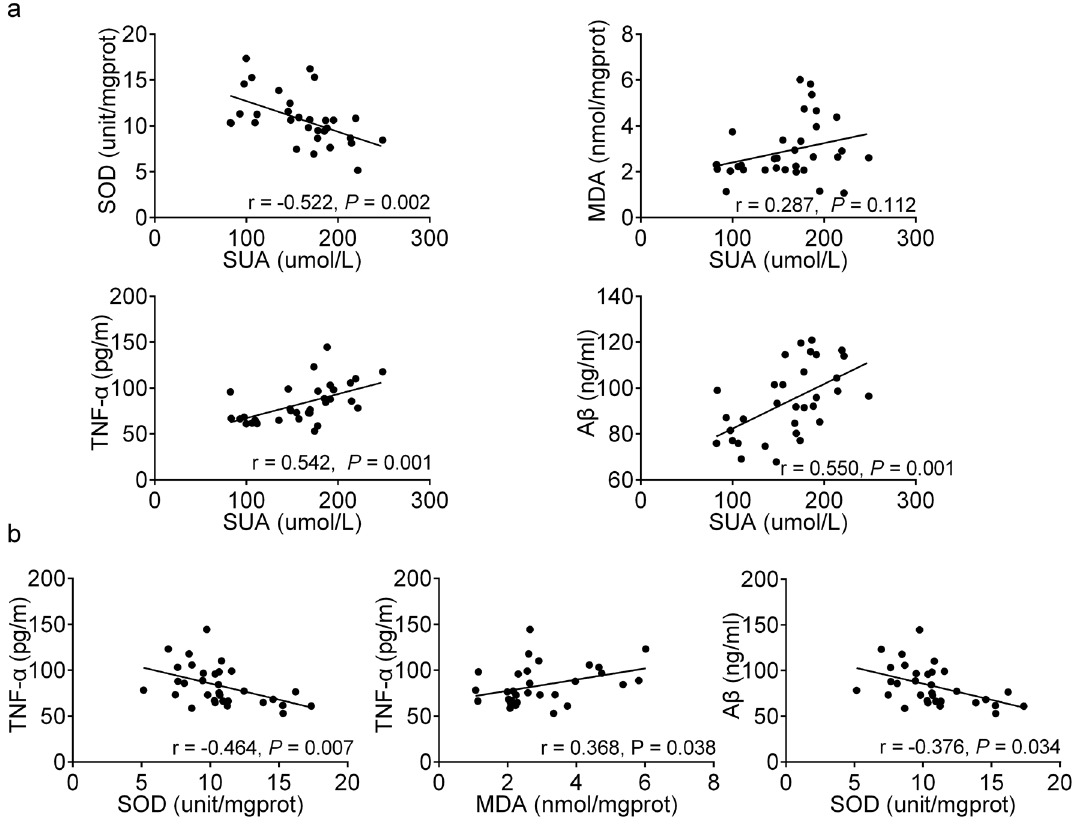
Figure 4. Associations between SUA at week 48, oxidative stress, inflammation cytokines and Aβ. n (subjects’ count) =